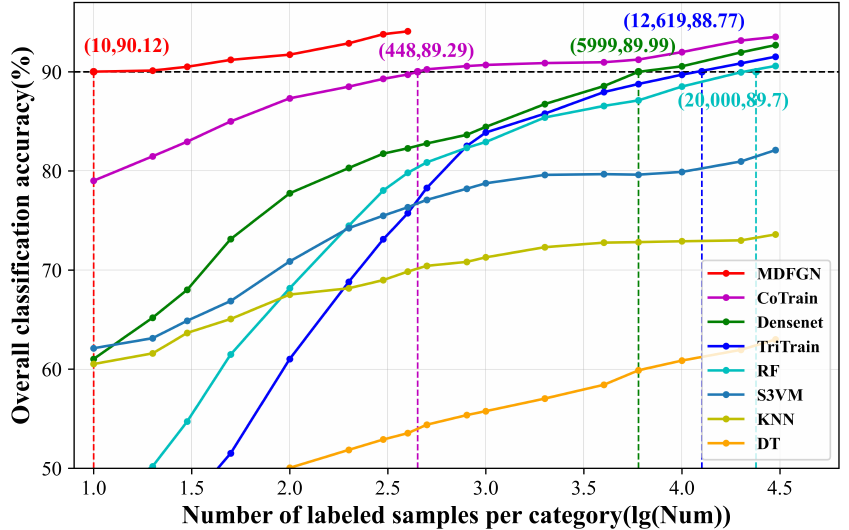
Figure 16. Overall accuracies of different methods varying with the number of labeled samples for the As-Flevoland